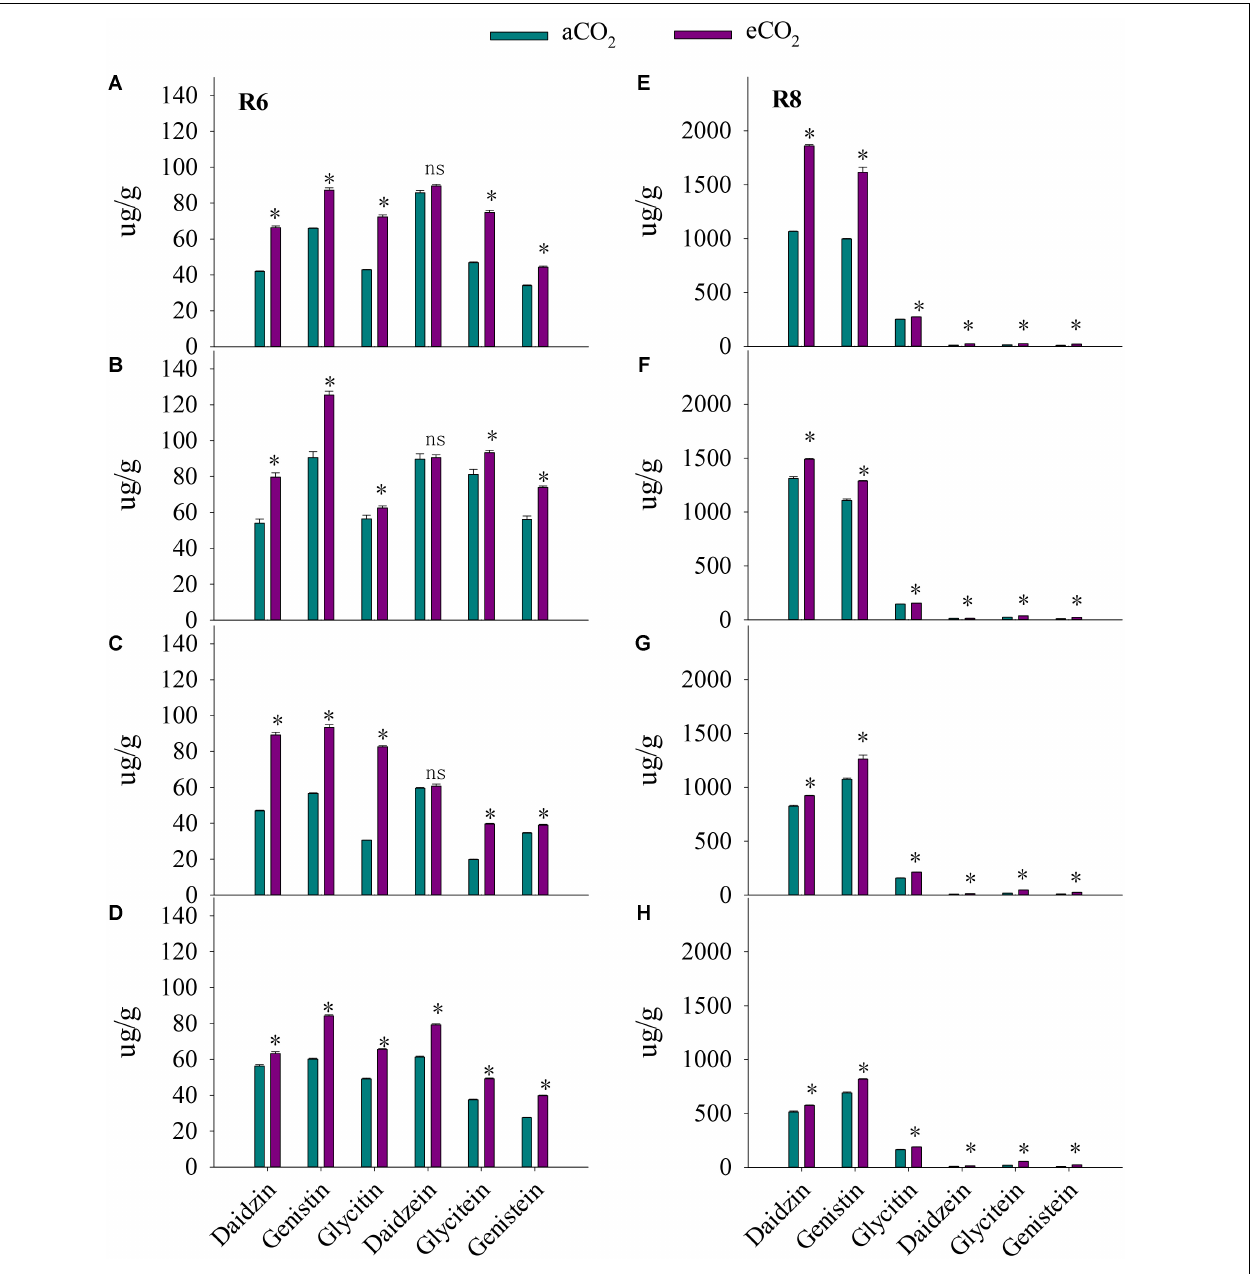
FIGURE 5 | Influence of elevated CO 2 on isoflavone concentrations of ZK-1 (A) , ZK-2 (B) , ZK-3 (C) , and HD (D) at the fresh edible stage (R6) and ZK-1 (E) , ZK-2 (F) , ZK-3 (G) , and HD (H) at the mature stage (R8); error bars represent the standard error ( n = 3). Significant differences between CO 2 treatments for each cultivar are noted with an asterisk at P <